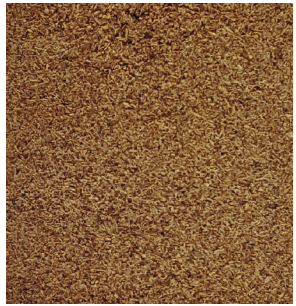
Fig. 12. Thin-fibre composite.